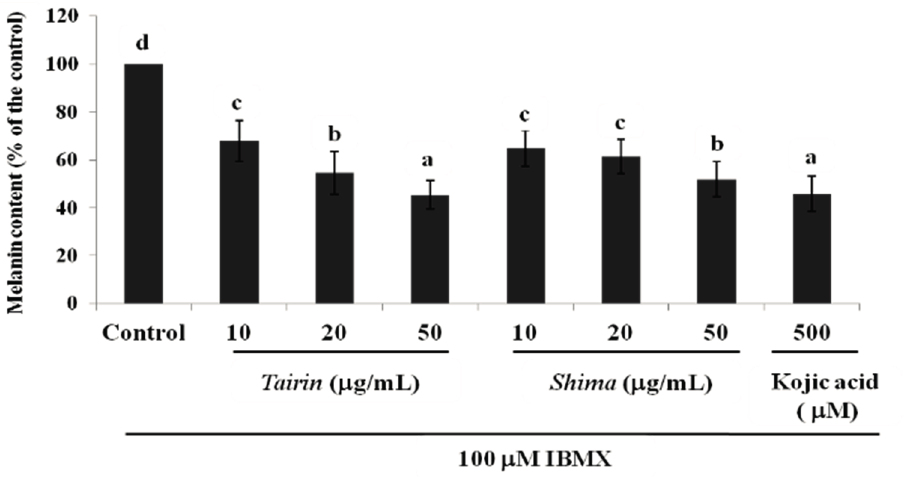
Figure 5. Effect of tairin and shima essential oils (EOs) on melanin production in B16F10 melanoma cells. B16F10 cells were treated with various concentrations of EO and incubated for 48 h. The melanin content of B16F10 melanoma cells was measured with a microplate reader at 490 nm. Values shown represent the mean ± standard error for three independent experiments. A one-way ANOVA was used for the comparison of multiple group means, followed by the Duncan test ( p < 0.05). Letters with different superscripts indicate samples that are significant different ( p < 0.05) from each